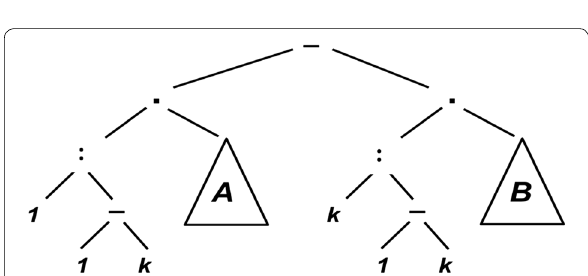
Fig. 4 A tree representation of the globally optimal solution P opt , where A and B are optimally aligned programs.